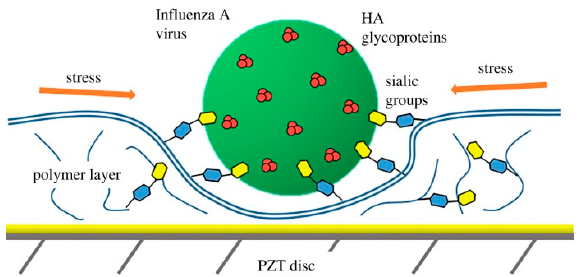
Figure 17. Portable biosensing system using a Bluetooth connection between a smartphone and the field-effect transistor-based biosensor. Reproduced with permission from [131].